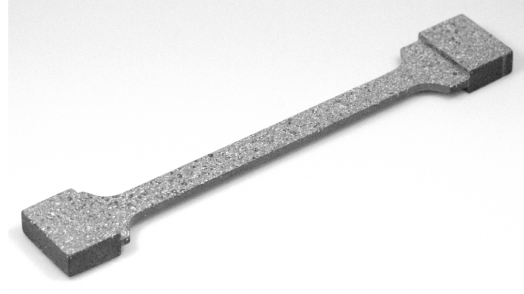
Figure 2. Visualization of sample shape.